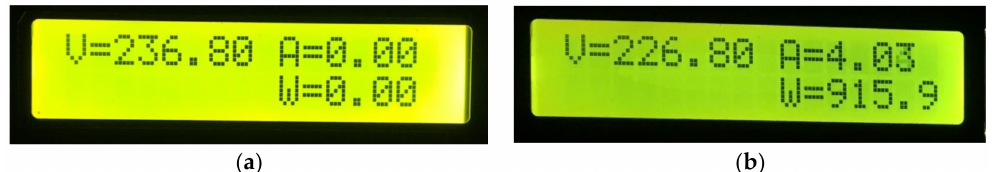
Figure 5. Measured data ( a ) without and ( b ) with connected